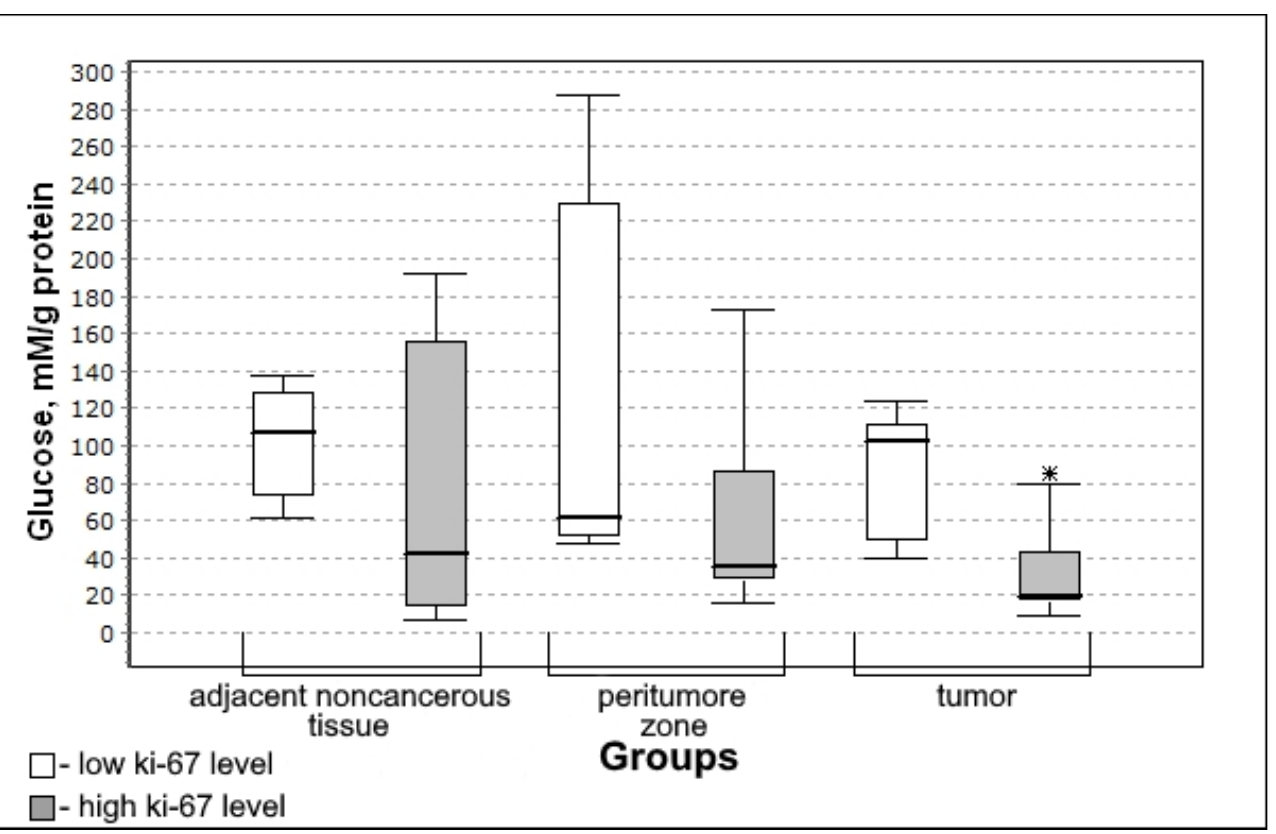
Figure 7. Medians and interquartile ranges (IQR) of concentrations of glucose in glioma tissue depending on the value of the mitotic index Ki-67 (low Ki-67 n = 7; high Ki-67 n = 13). Statistics are reported * p < 0.05.